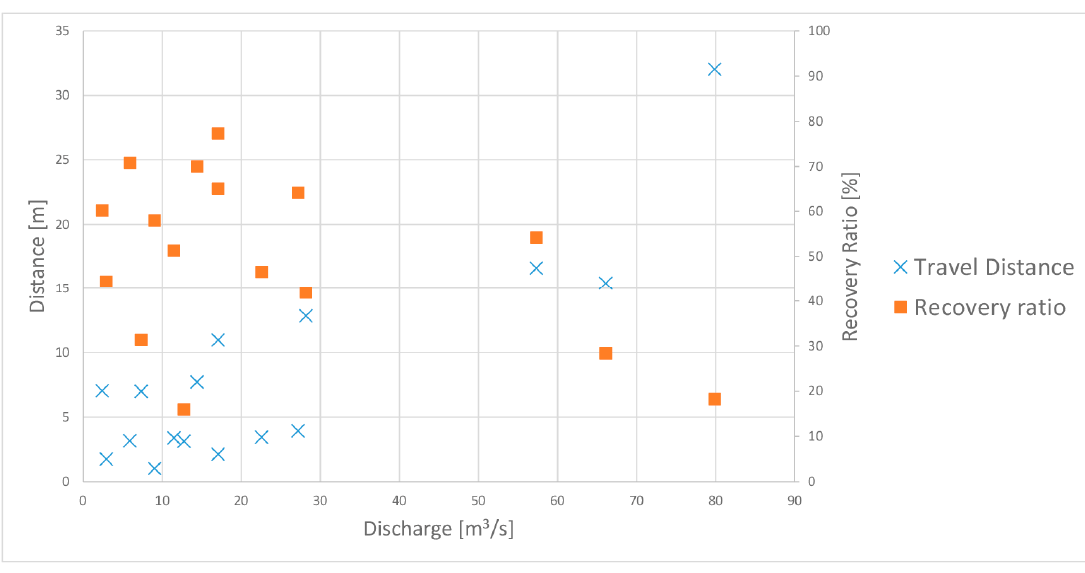
Figure 5. Covered distance (blue crosses) and recovery ratio (orange squares) plotted versus measured peak discharge for each event. It is possible to notice a weak direct relationship between distance and discharge and inverse between recovery ratio and discharge. Recovery ratio is also affected by new tracer insertion.